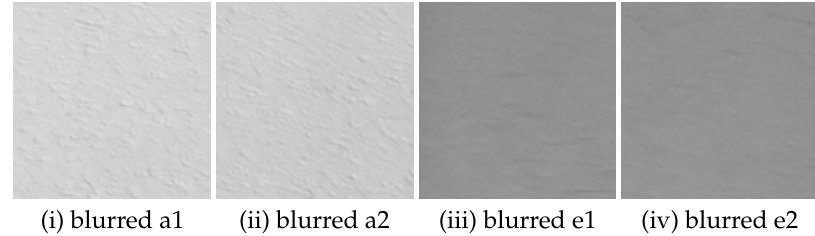
Figure 13. Examples of blurred sub-image from area A and E (121 × 121